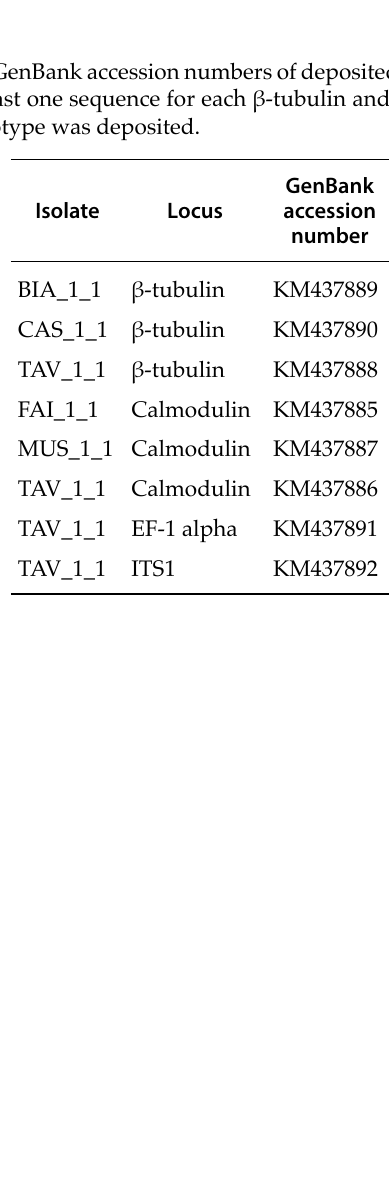
Figure 7. Haplotype networks of A) β-tubulin sequences and B) calmodulin sequences. Five isolates from each sam- pling site and three reference isolates were used to con- struct the networks.